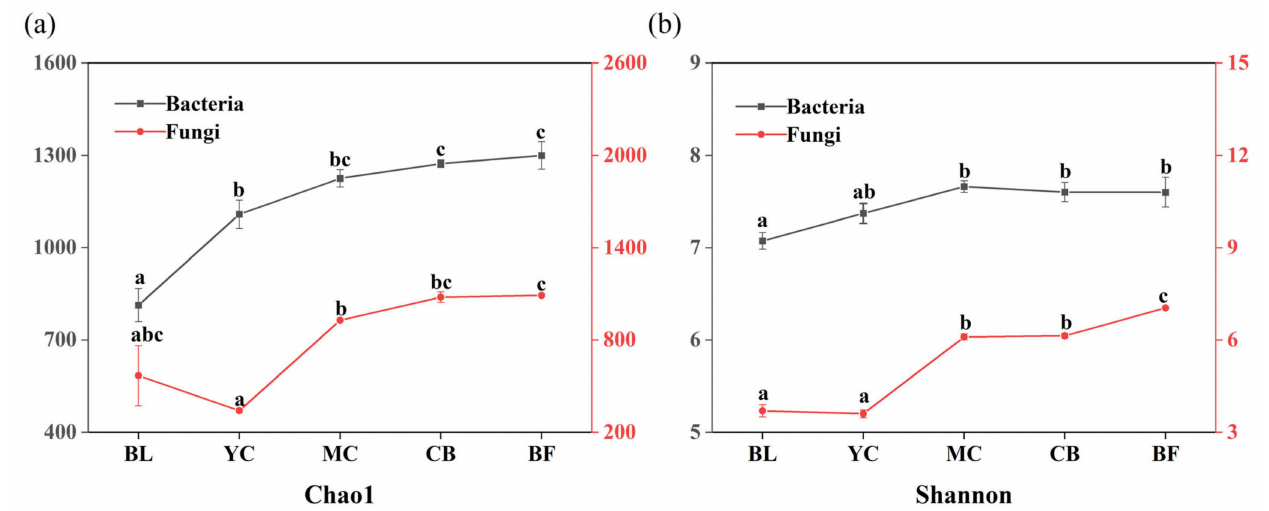
Figure 4. Soil bacterial and fungal alpha diversity measurements in sites YC, MC, CB, and BF compared to control sites (BL). The black line and the axes indicate the alpha diversity of the bacterial community, while the red line and the axes indicate the alpha diversity of the fungi. Values are means ± SE (n = 3). Different letters above the datapoints indicate significant differences ( p < 0.05) in bacterial/fungal diversity measures among sites according to the least significant difference (LSD) test or Tamhane’s T2 test. The alpha diversity measures of Chao 1 (richness) ( a ) and Shannon (diversity) ( b ) in soils from sites of different forest types. BL: bare land; YC: newly restored young coniferous forest; MC: slightly more mature coniferous forest; CB: mixed coniferous and broadleaf forest; BF: broad-leaved